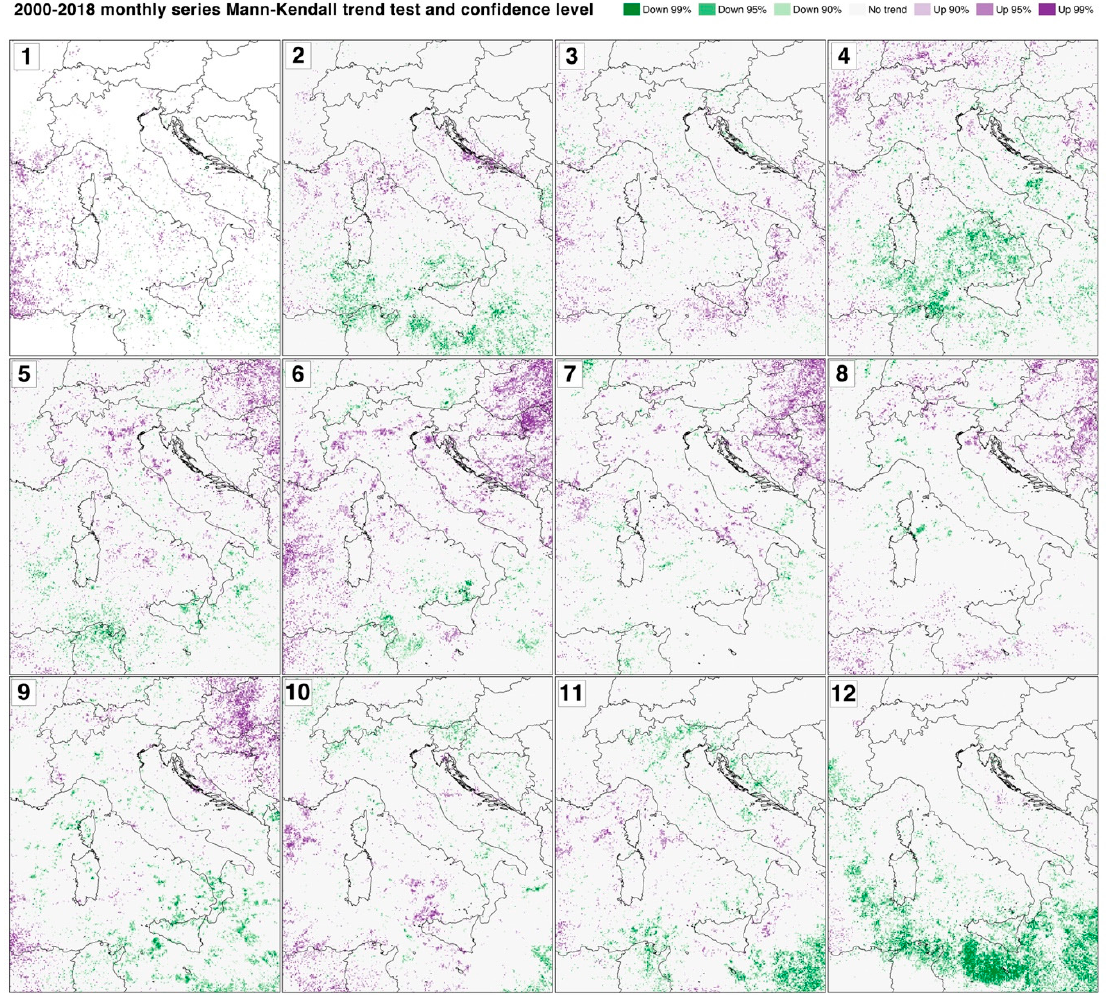
Figure 4. Spatial Mann–Kendall trend test for the monthly series in the 2000–2018 period with 90%, 95%, and 99% confidence level. 1: January; 2: February; 3: March; 4: April; 5: May; 6: June; 7: July; 8: August; 9: September; 10: October; 11: November; 12: December.